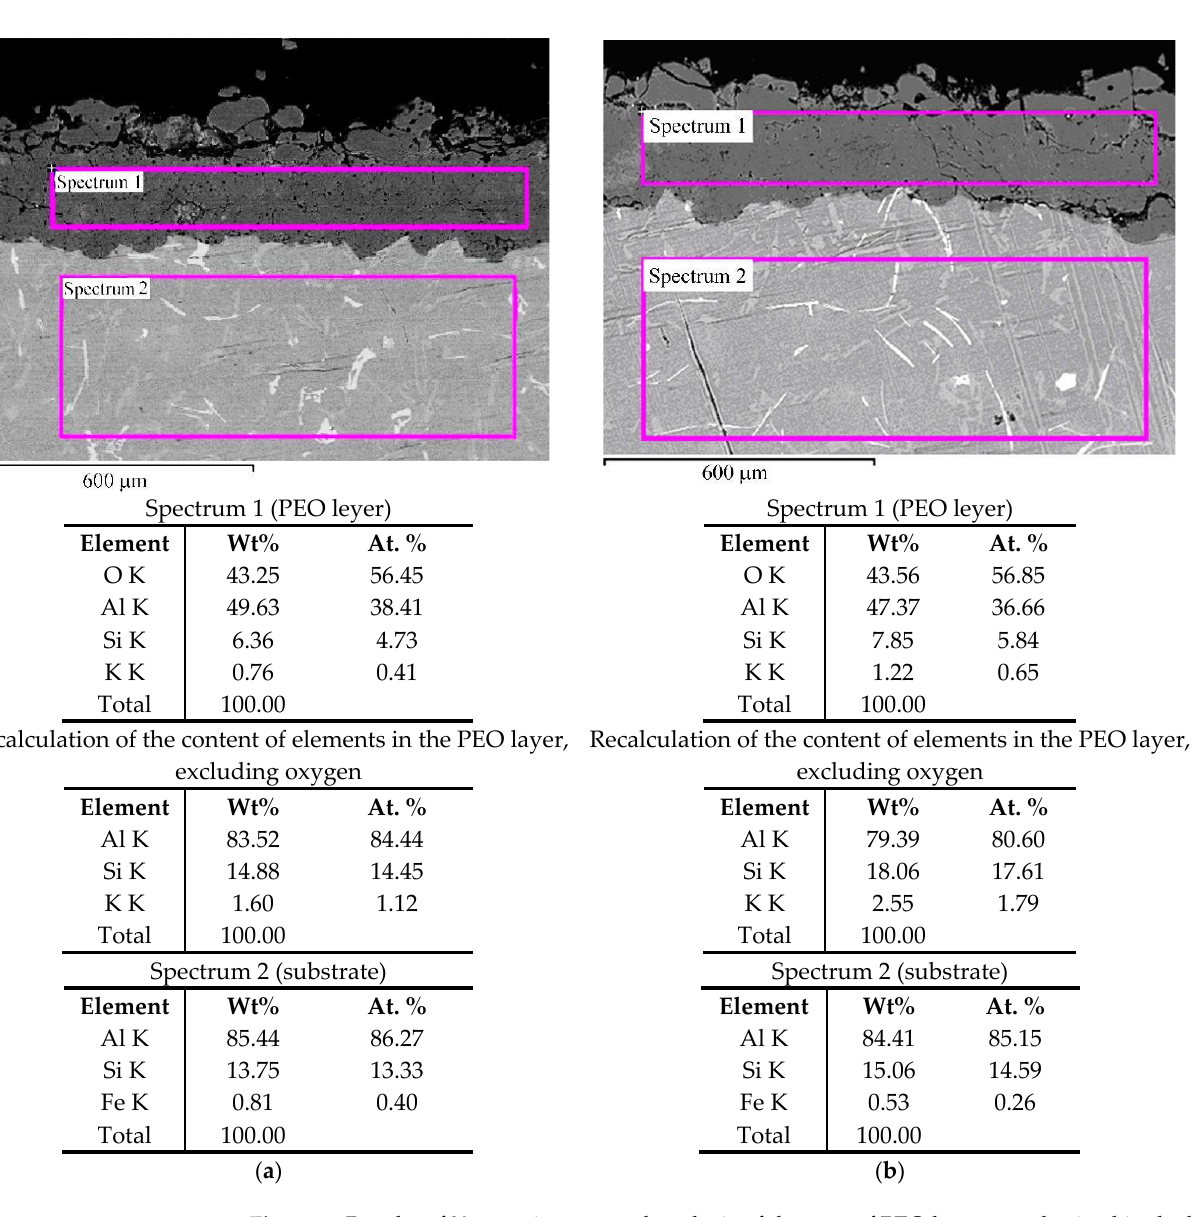
Figure 3. Results of X-ray microspectral analysis of the area of PEO layers synthesized in the base electrolyte on the surface of two cast aluminum alloys AK9 ( a ) and AK12 ( b